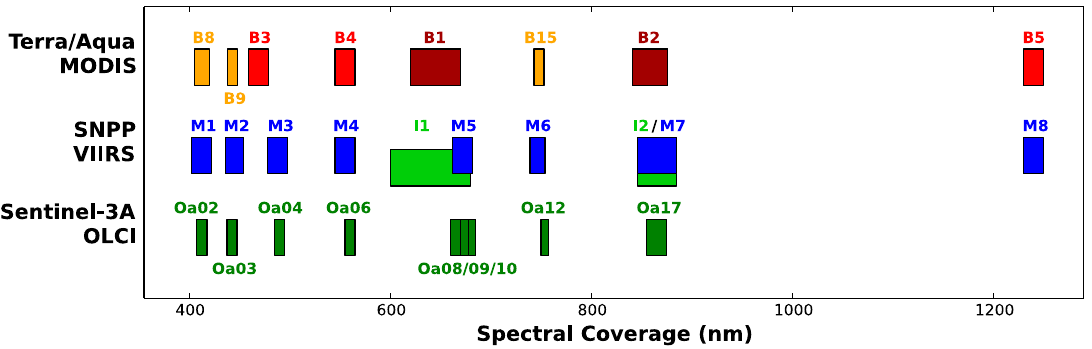
Figure 1. The spectral coverage of the selected reflective solar bands (RSBs) of MODIS, SNPP VIIRS, and Sentinel-3A OLCI considered in this study. The 250-m, 500-m, and 1-km spatial resolution MODIS bands are shown in orange, red, and purple, respectively. The 750-m and 375-m spatial resolution bands of SNPP VIIRS are shown in blue and light green.